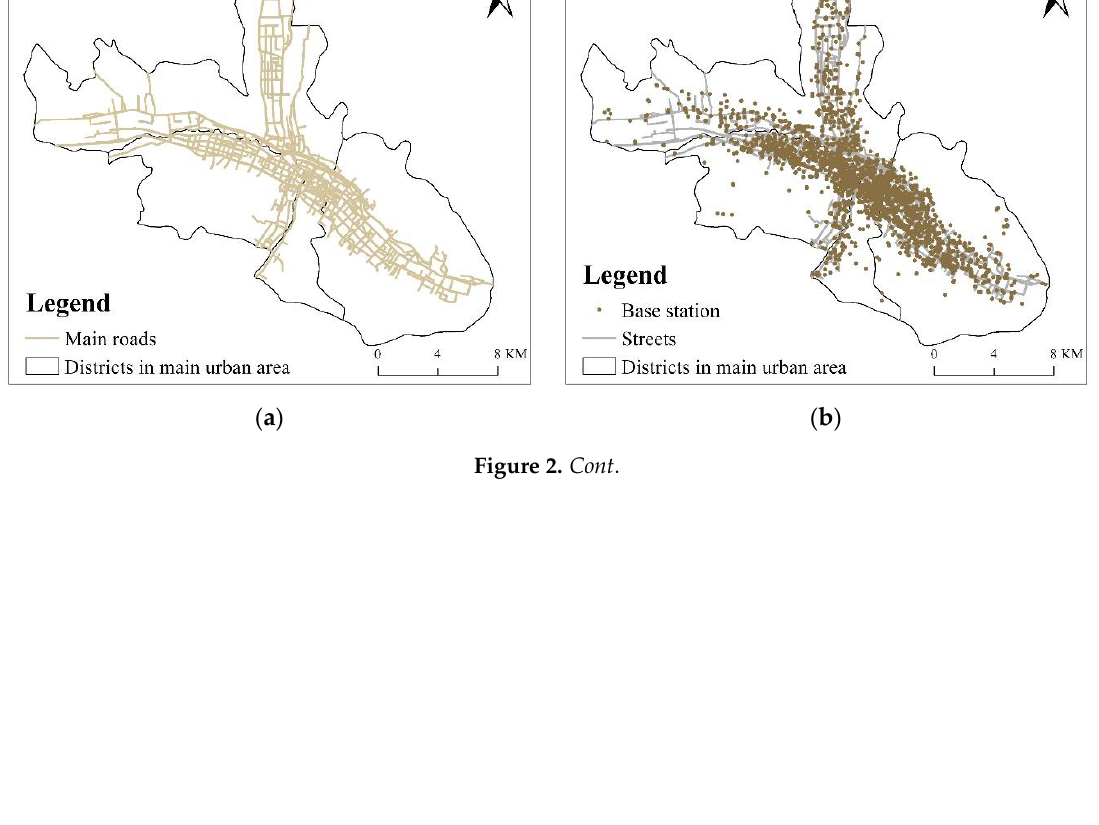
Figure 2. Spatial distribution of the elements from the four data sources. ( a ) Main roads; ( b ) Base station; ( c ) Buildings; ( d ) points of interest (POIs). 3. Methodology 3.1. Street Dynamic Vitality We used the population density at each time period to represent street dynamic vi- tality. The urban spatial data reflected the three-dimensional space where vitality oc- curred, the Thiessen polygon approximately represented the service range of the base sta- tions, and the mobile phone communication data at different time periods quantified street dynamic vitality. The built environment affects the subjective feelings and activities of crowds [24]. The three-dimensional space enclosed by a road intersection is a complete space through which the elements within the built environment affect people’s feelings and the integrity of their activities. Therefore, using the processed road network data, we considered the space enclosed by two road intersections as a street (streets with a length less than 200 m were not divided by intersections). Finally, we obtained 652 streets in the main urban area of Xining city. The time units of the mobile communication data were accurate to the second, and the spatial sampling accuracy of the mobile communication was about 160 m in our study. Table 1 presents the information of the acquired mobile communication data.